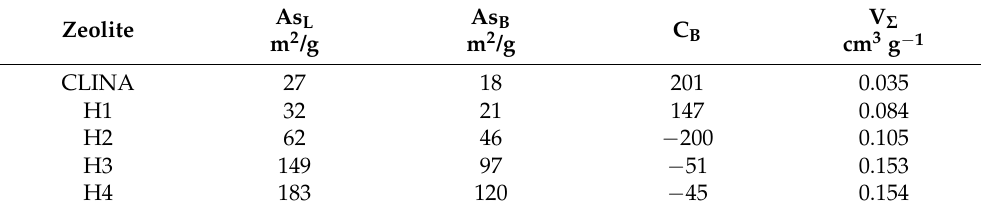
Table 4. Textural parameters of natural (CLINA) and H-modified clinoptilolite zeolites.